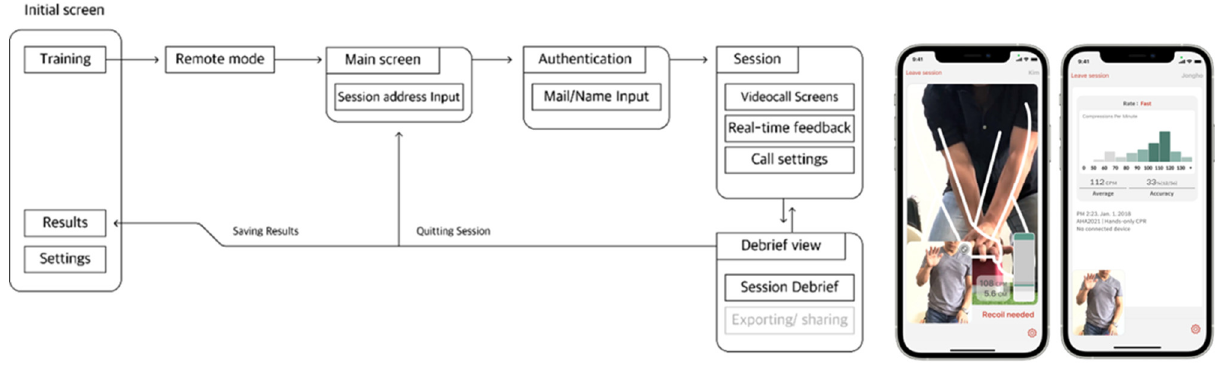
Figure 3. Flow map ( left ) and User Interface ( right ) of Student application.